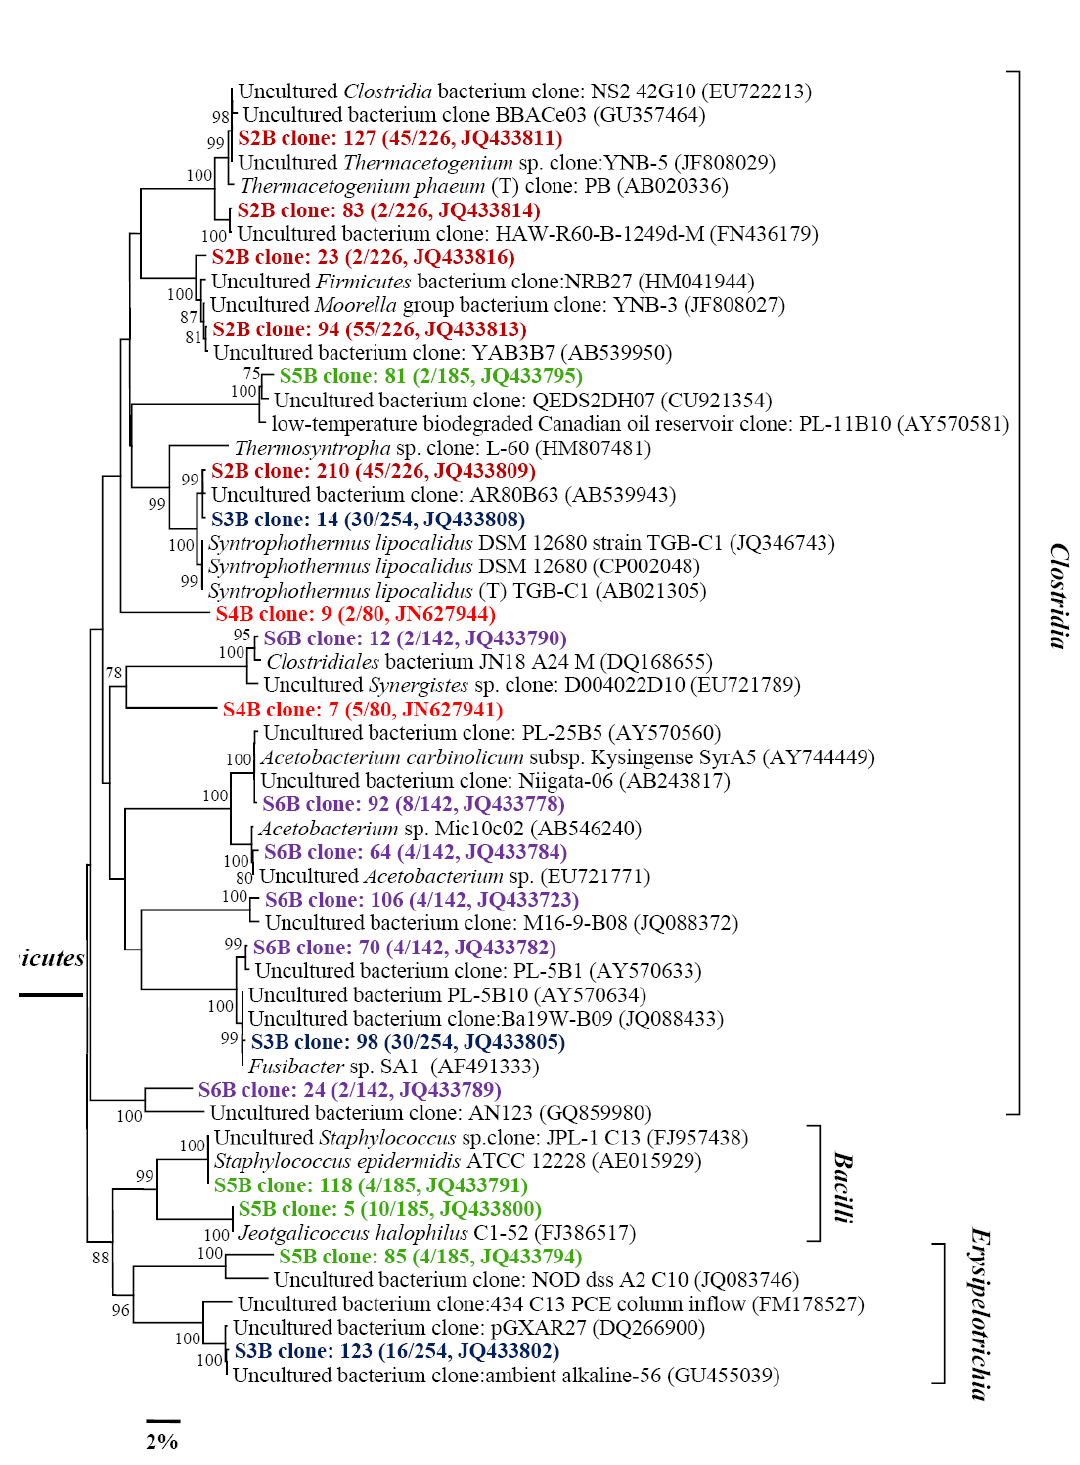
Fig. 2 : Phylogenetic tree of the Firmicutes 16S rRNA gene phylotypes retrieved from six different petroleum reservoirs (shown in bold) and closely related sequences from GenBank database. Alignments to related sequences (shown with accession number) were performed with MEGA 5 software. The topology of the tree was obtained with the neighbor-joining method. Bootstrap values ( n = 1000 replicates) of ≥ 75% are reported. Scale bar represents nucleotide changes per site. Sampling locations are as named in Table